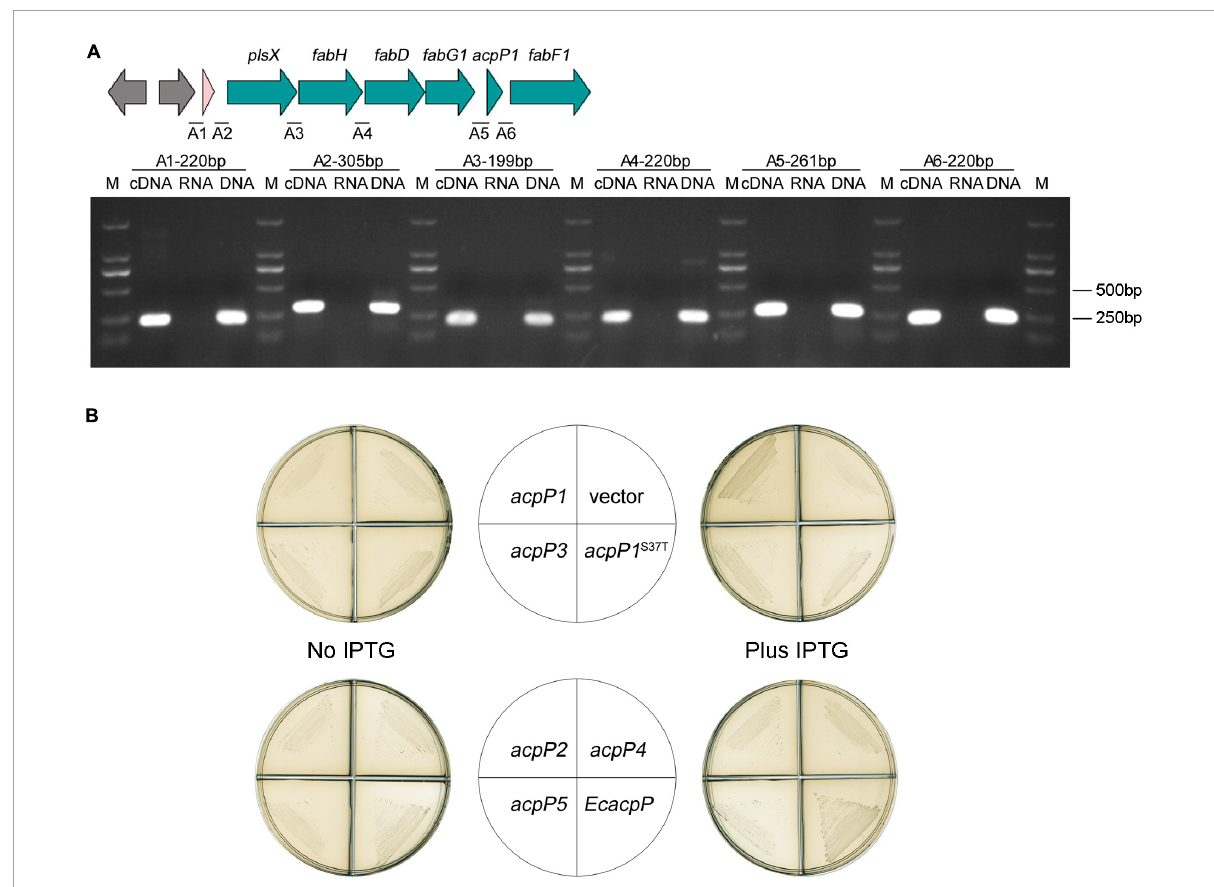
FIGURE4 Only AcpP1 partially restored the growth of E . coli acpP- mutant strain. (A) RT-PCR of the intergenic regions. cDNA, RNA, or DNA from the GMI1000 strain was used as the template for PCR. The intergenic regions and lengths are marked above each lane. M: DNA marker DL2000. (B) Complementation of E . coli acpP mutant strain CY1877 with R . solanacearum acp genes. Strains CY1877 carrying IPTG-inducible expression vector pTac85 expressing an acp gene (as shown in the middle panels) were cultured on RB plates for 24 h. Left panels showed RB medium without the supplement of IPTG; right panels showed RB medium supplemented with IPTG; vector,